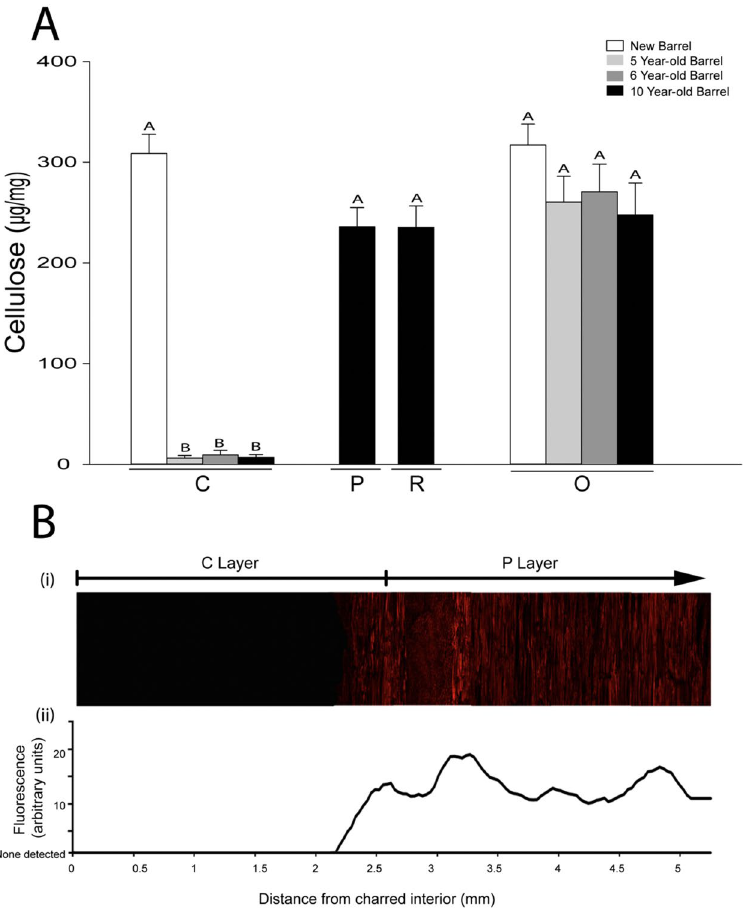
Figure 4. Cellulose is lost from the C layer after aging. ( A ) The cellulose content of the C and O layers of a new barrel, a five-year-old barrel and a six-year-old barrel, and the C, P, R and O layers of a ten-year-old barrel were measured using values that were obtained by the Updegraff method and are presented as micrograms of cellulose per milligram of barrel material. A Tukey-Kramer multiple comparison test was used to determine statistical significance (n = 12; different letters denote statistically significant differences at P < 0.05; error bars indicate standard error). ( B ) The cellulose content gradually increases with distance from the charred interior of the ten-year-old barrel stave. Confocal microscopy image using Pontamine S4B to stain crystalline cellulose ( i ). The lack of crystalline cellulose in the C layer can be seen by the absence of fluorescence. Relative fluorescence was measured across the image showing a gradual increase in crystalline cellulose with distance from the charred interior ( ii